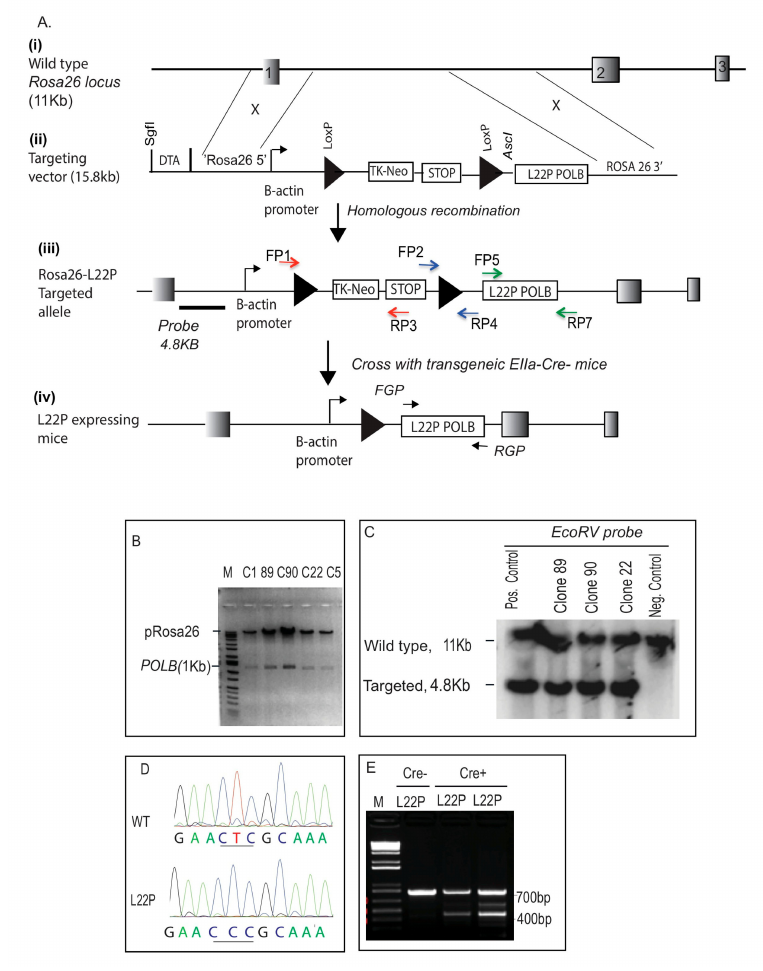
Figure 1. Conditional targeted knock-in mice at the ROSA26 locus. ( A ) Schematic of the construction of the conditional L22P floxed allele. (i) ROSA26 locus at chromosome 6 indicated as Exon 1, 2, and 3; (ii) Targeting construct of POLB ; (iii) Targeted construct integrated at ROSA26 locus via homologous recombination; Targeted alleles in embryonic stem (ES) cells were genotyped using allele-specific PCR at three di ff erent regions of the construct using di ff erent primer sets that are indicated with red, blue, and green (all primers listed in Table S1); Linear plasmid digested with SgfI was electroporated into ES cells derived from the B6 / 129SvJ strain; Neomycin genes flanked by the loxP site and diphtheria toxin (DTA) were used for positive and negative selection,